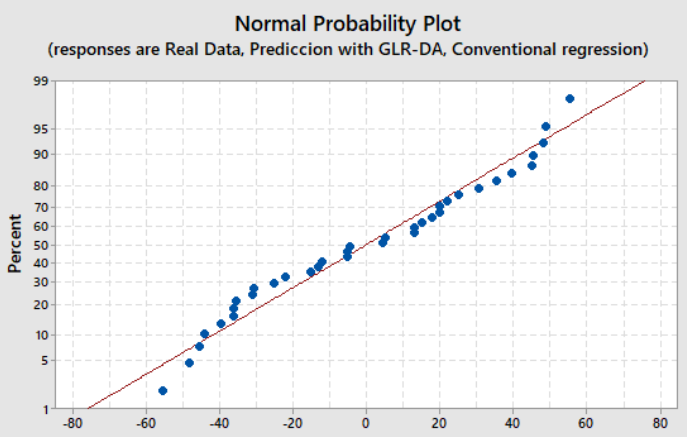
Figure 2. Normal